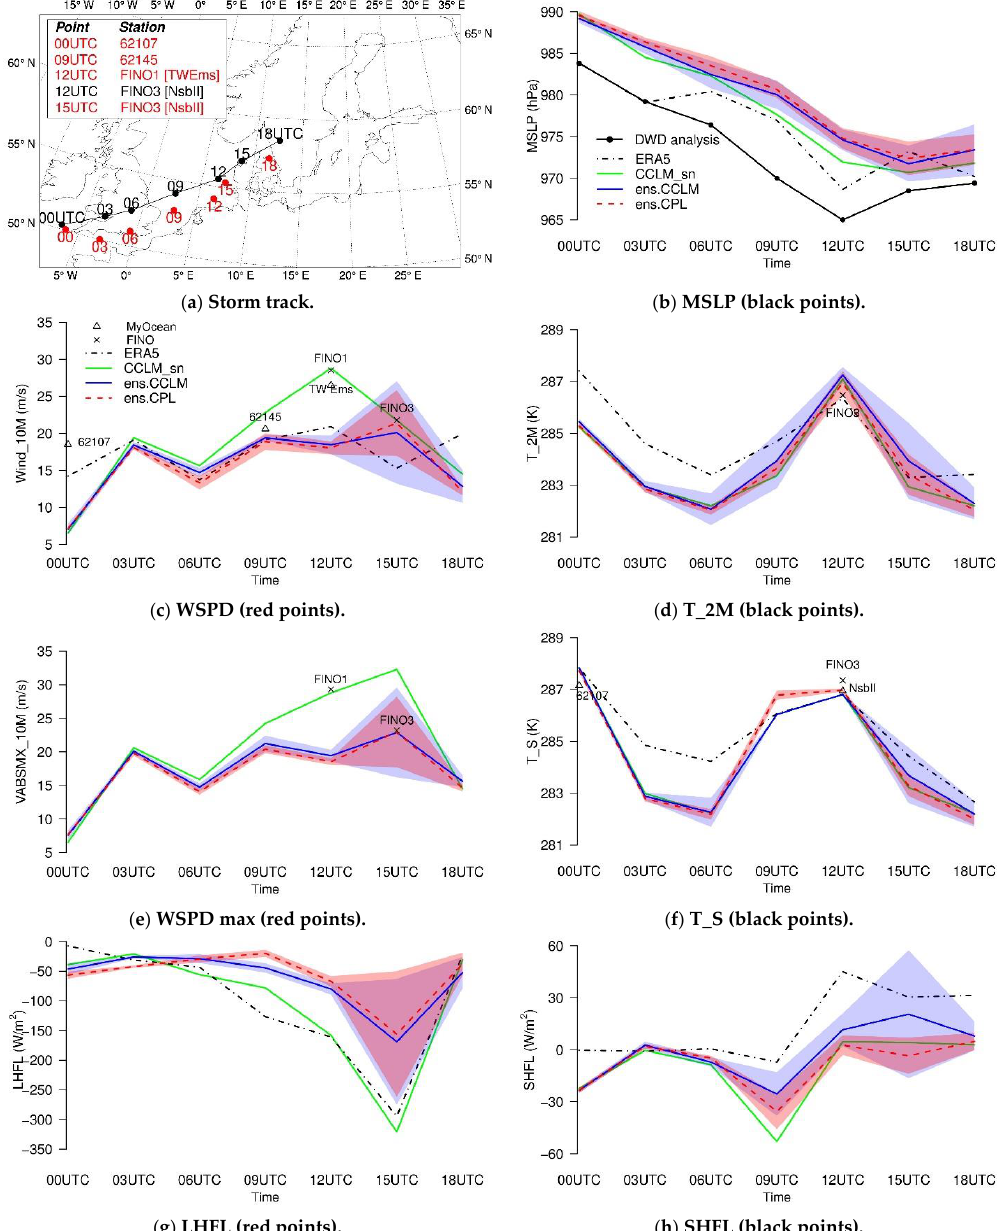
Figure 15. ( a ) The storm track of the storm Christian from DWD analysis (black line and points) and locations of maximum wind speed (red points). The three-hourly evolution of ( b ) mean sea level pressure MSLP ( hPa), ( c ) 10-m height wind speed Wind_10M(m/s), ( d ) 2-m height air temperature T_2M (K), ( e ) 10-m height maximum wind speed VABSMX_10M (m/s), ( f ) surface temperature T_S (K), ( g ) surface latent heat flux LHFL (W/m 2 ) and ( h ) surface sensible heat flux SHFL (W/m 2 ) . Figure 15b,d,f,h shows values at the black points in Figure 15a while Figure 15c,e,g shows values at the red points. Blue and red shades indicate the ensemble spreads of ens.CCLM and ens.CPL, respectively. Time period: 00UTC-18UTC, 28 October 2013.